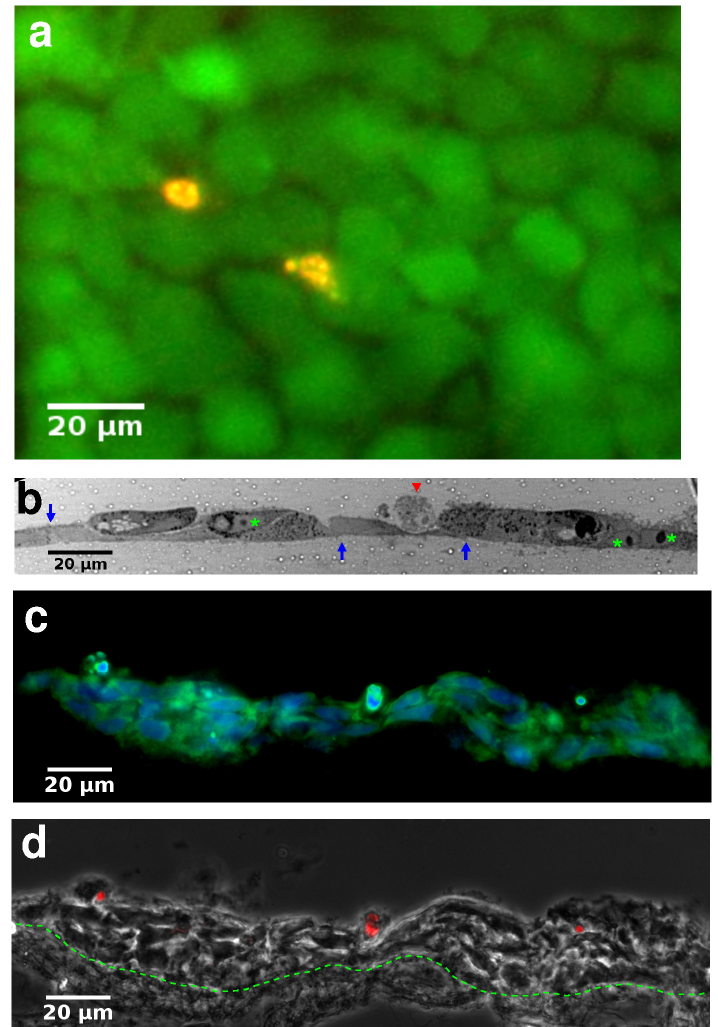
Figure 2. Histology of skin equivalents. ( a ) Live/dead labeled image of a monolayer of HaCaT keratocytes, imaged on the electrospun membrane at day 25 in culture. Calcein (green) fluorescence shows live cells while dead cell nuclei are identified by ethidium (red) fluorescence. Co-localization of green and red fluorescence appears as yellow. ( b ) Toluidine blue-stained semi-thin section of a monolayer of cells at day 18 in culture. Blue arrows point to cell-cell junctions, asterisks indicate cell nuclei with apparent nucleoli, red arrowhead marks an apoptotic cell. ( c , d ) Frozen cross-sections of a keratinocyte culture kept in culture for 28 days and at the air-liquid interface (ALI) for 14 days. ( c ) Cells and nuclei are visualized with calcein (green) and NucBlue (blue) fluorescence. ( d ) Phase- contrast image of the same field shown in ( c ) merged with ethidium fluorescence (red), identifying dead cells. Dotted line indicates the border between the cell layer and the electrospun membrane. Scale bars: 20 µ